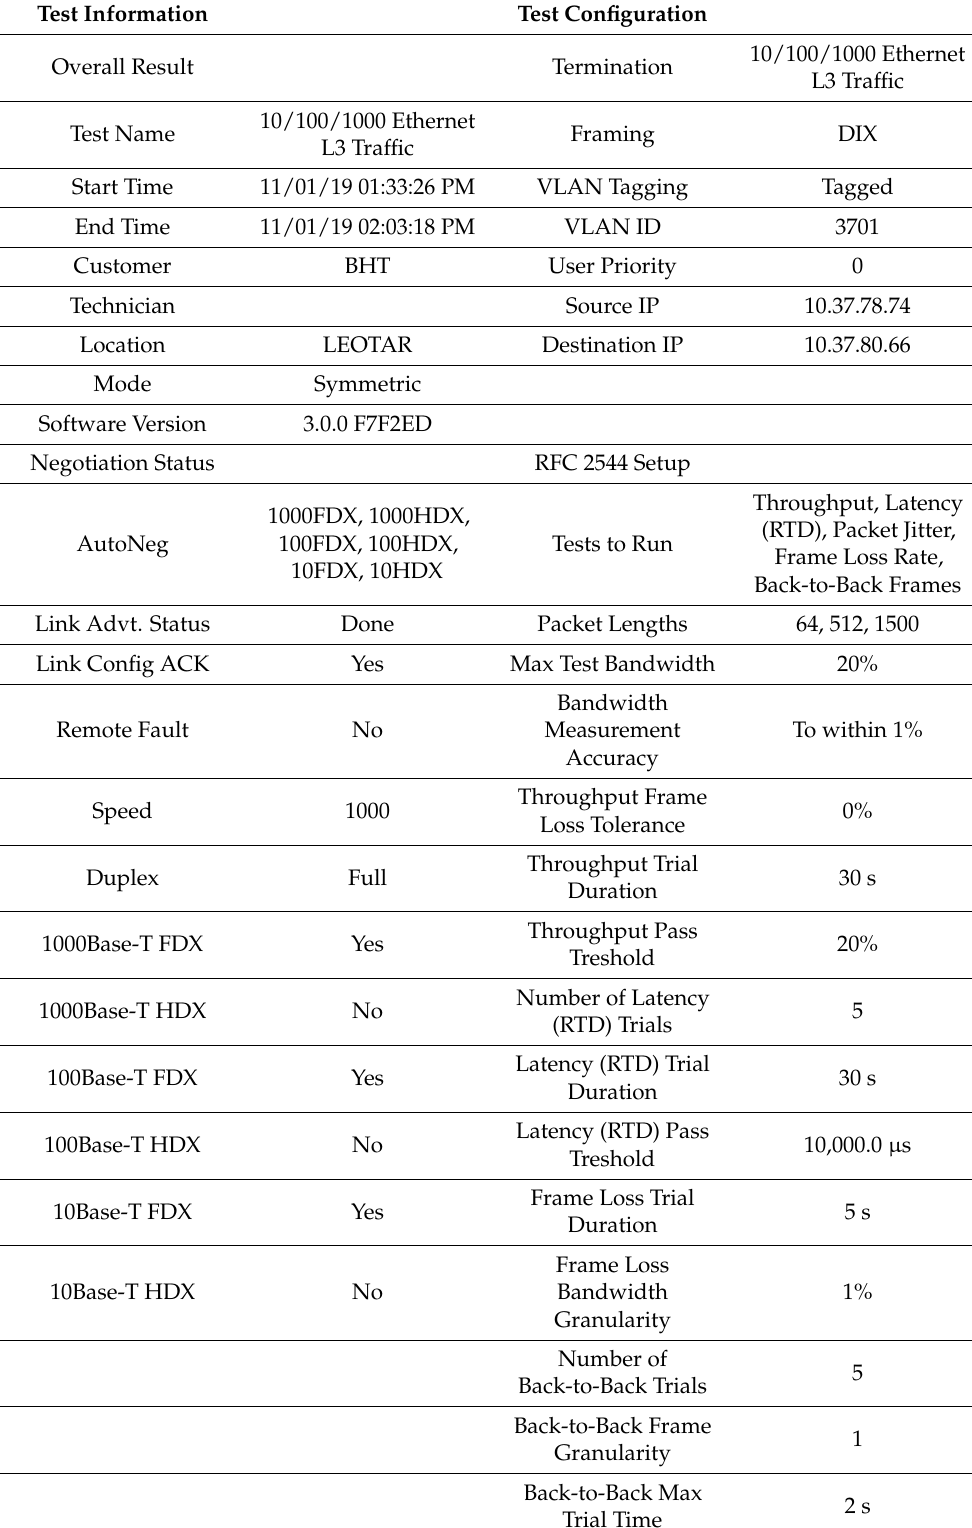
Table 2. Ethernet test settings